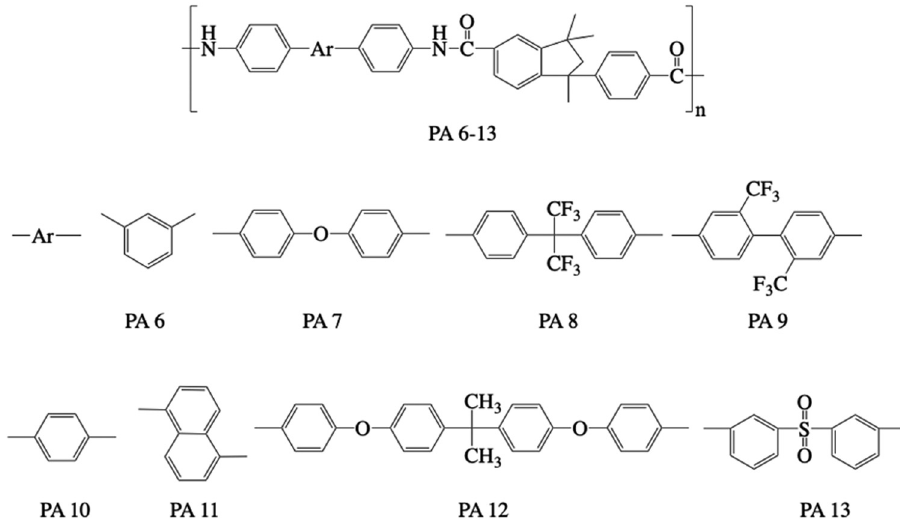
Figure 4: Structure of the polyamides having indene moiety ( 61 ) .